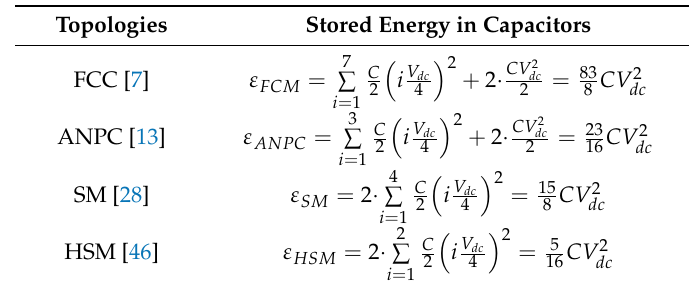
Table 2. Capacitor stored energy for FC-based multilevel converters.